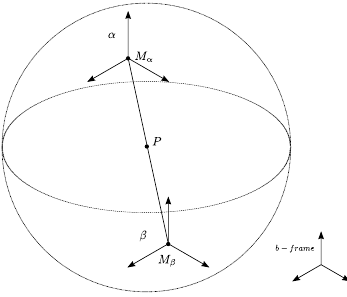
Figure 2: Position of the two triads ( α and β ). The point P on this figure belongs to ( M α M β ) and corresponds to the vehicle reference point. The sphere diameter is about 40 cm .